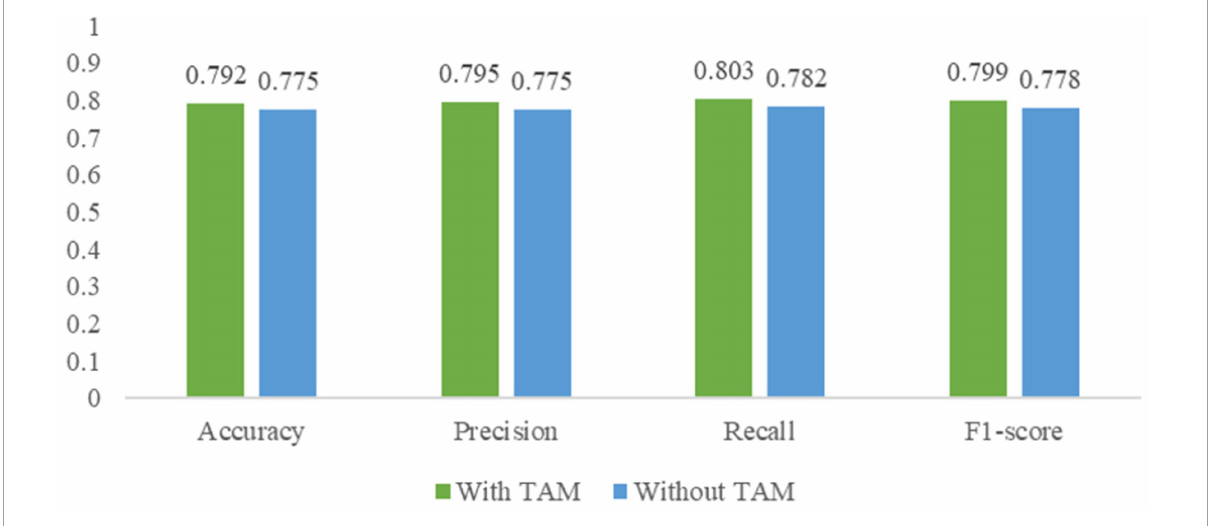
FIGURE10 Performance comparison of I3D without temporal attention module (TAM) and I3D with TAM.